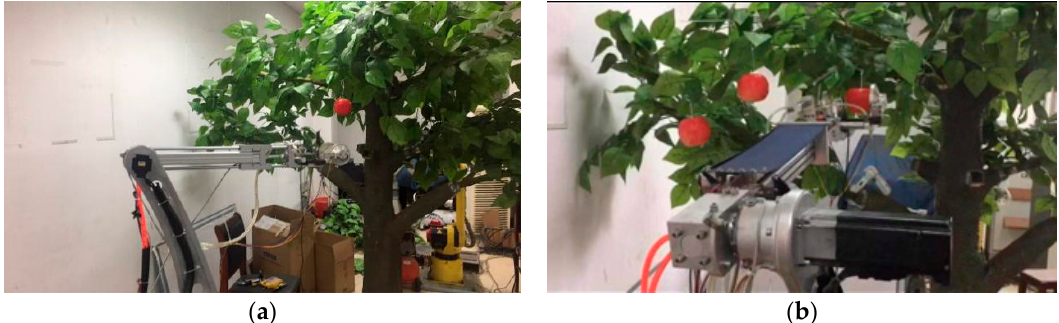
Figure 16. ( a ) Representing the movement process of the robot arm of apple-picking robot; ( b ) Representing that the picking machine recognizes the target and controls the robot arm to grasp the target through the algorithm presented in this paper. Table 3. Experimental results.